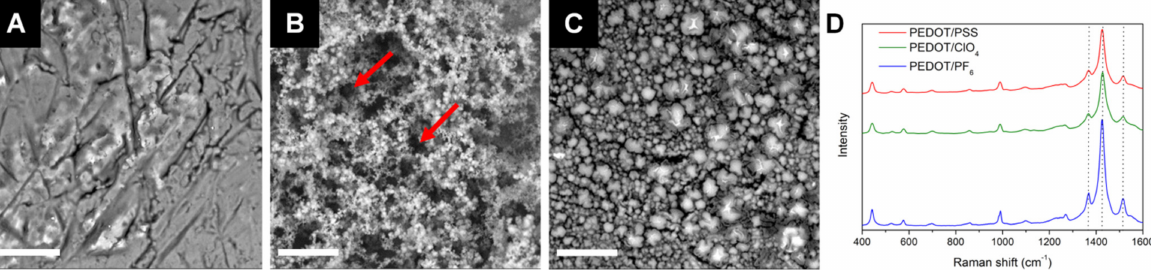
Figure 2. Surface characterization. SEM images obtained at 15 kV for ( A ) PEDOT/PSS, ( B ) PEDOT/PF 6 , and ( C ) PEDOT/ClO 4 ; scale bar represents 30 µ m. Red arrows indicate pores in the polymer structure. ( D ) Raman spectra of the polymer coatings collected over the range of 400–1600 cm − 1